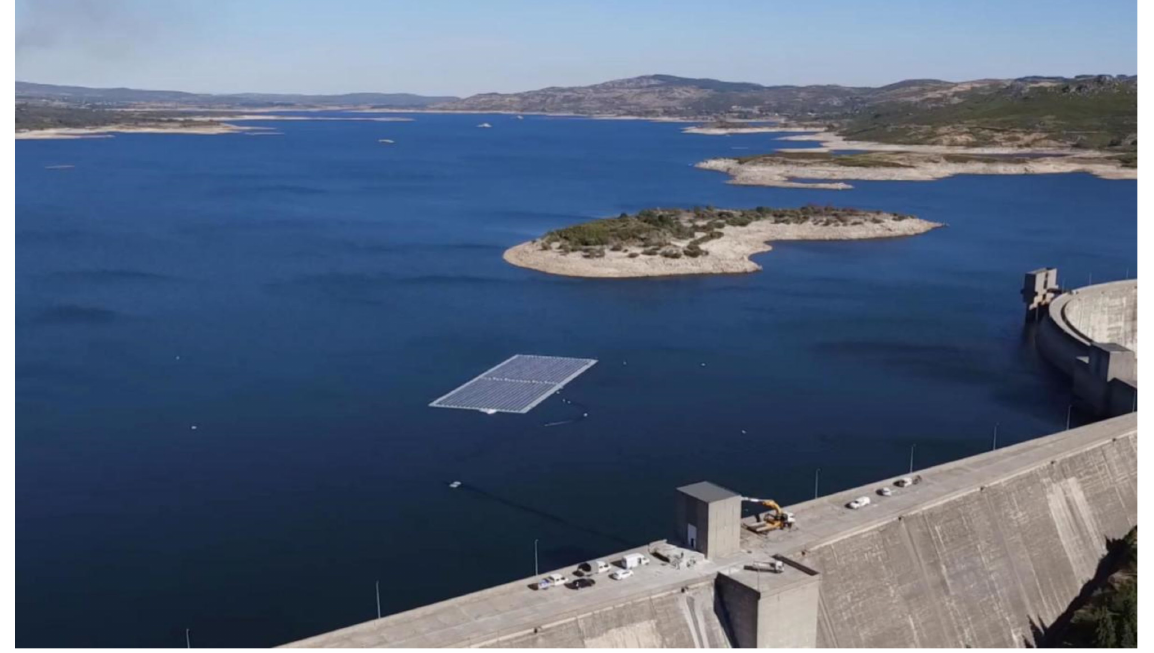
Figure 6. FPV with a pumped hydro “virtual battery” concept. (Copyright EDP S.A., photo by Pixbee).